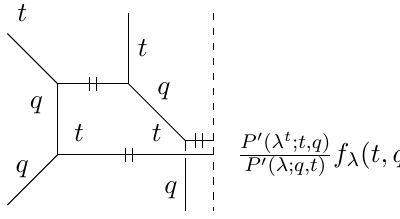
Figure 9 . Realization of the D 2 quiver with U(1) (cid:2) U(1) gauge group by topological vertices and orientifold